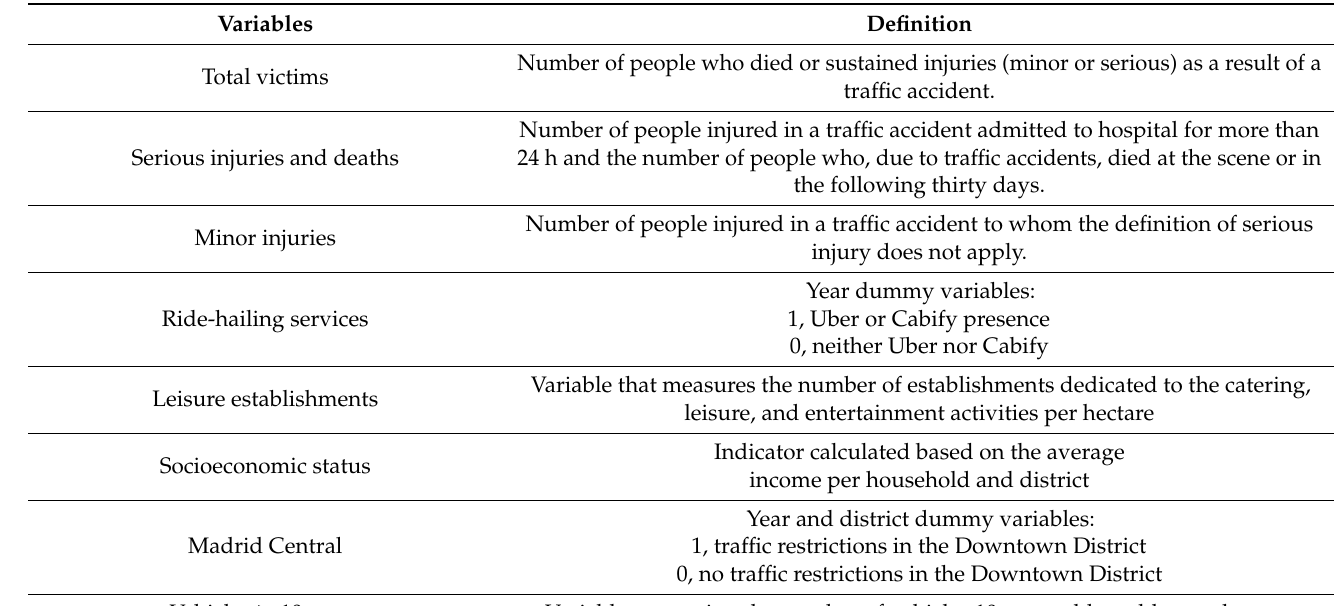
Table 1. Variables. Source: own